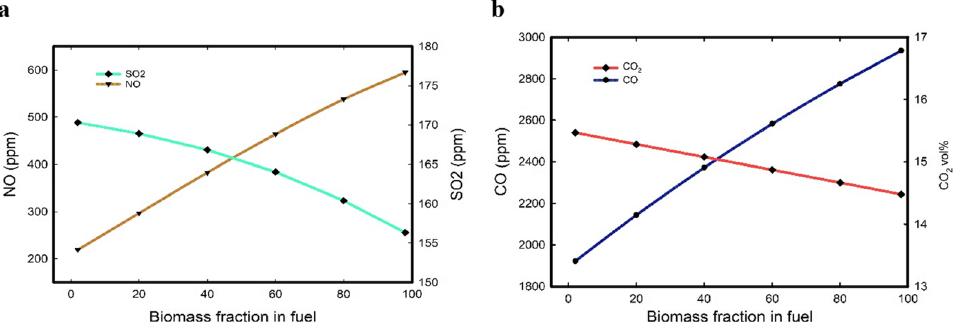
Fig. 2 a Effect of biomass fraction on SO 2 (right scale) and NO (left scale); b CO (left scale) and CO 2 (right scale) composition in flue gas at 1073 K, 101.325 kPa, 25 kg/h air flow